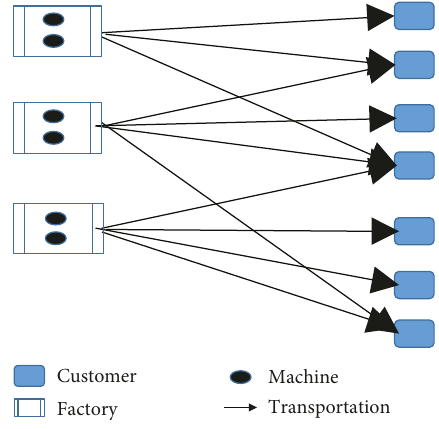
Figure 1: Supply chain